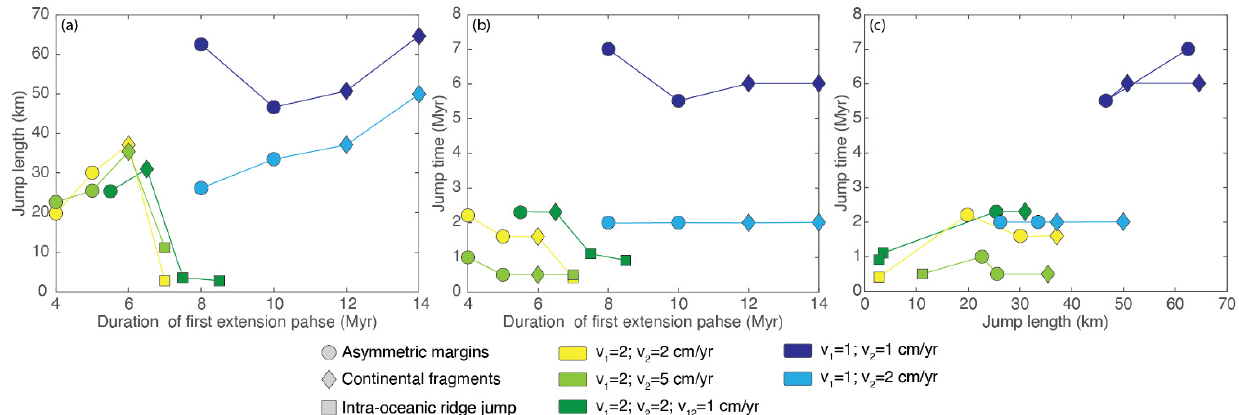
Figure 7. Plots showing the ( a ) length and ( b ) time of the rift/ridge jumps in all models as a function of the duration of the first phase of extension and ( c ) their relationship. Jump time is computed from the moment extension phase 2 starts. Different symbols represent the different observed scenarios: asymmetric margins (circles), continental fragment formation (diamonds), and intra-oceanic ridge jump (squares). Colours show the different extension velocities. Table 2. List of model’s parameters and results. For models with acceleration and deceleration during the transition phase, the jump time is computed from the moment acceleration starts, whereas for all the other models the jump time is computed from the moment extension phase 2